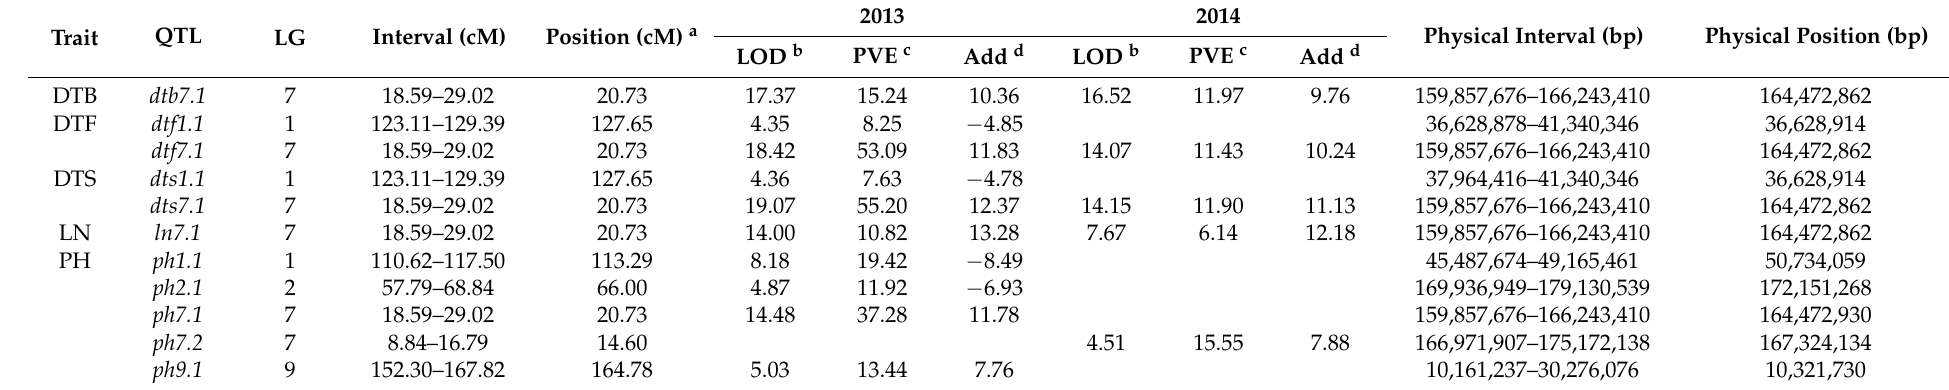
Table 4. Quantitative trait loci (QTLs), their positions (cM), logarithm of the odds (LOD), percentage of phenotypic variation (PVE), additive effects (Add.), and their physical position (bp) for bolting, stem elongation and flowering time related traits in a F5 RIL population developed from L. sativa cv. Chimasanchu × L. sativa cv. Banchu Red